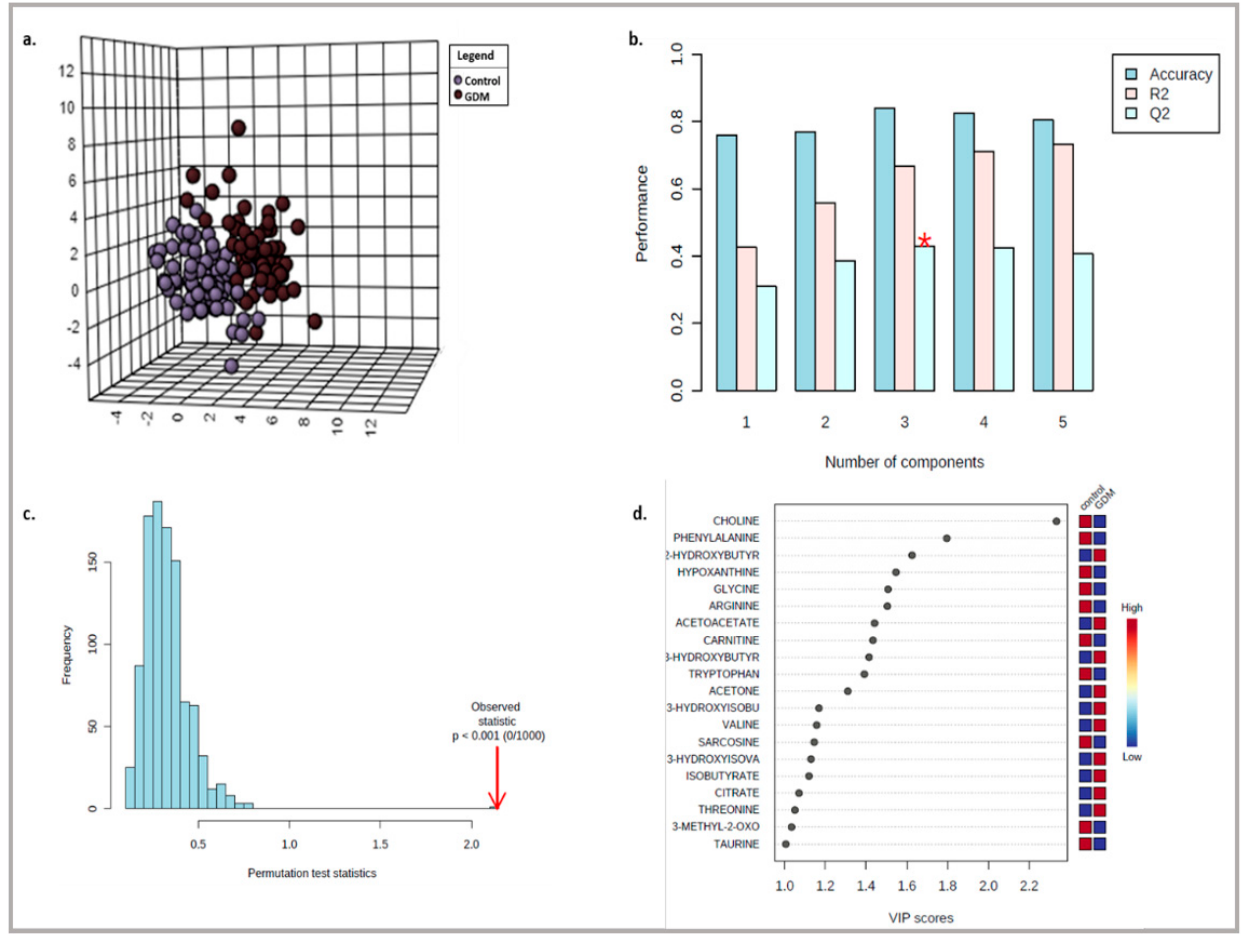
Figure 1. The PLS-DA multivariate analysis obtained for the 62 women with GDM and 77 healthy pregnant women: ( a ) Scores plot; ( b ) cross validation; ( c ) permutation test and; ( d ) the top 20 most discriminating metabolite GDM cases from control ranked by variable importance in projection (VIP) scores of PLS-DA model. VIP scores ≥ 1 were considered significant.